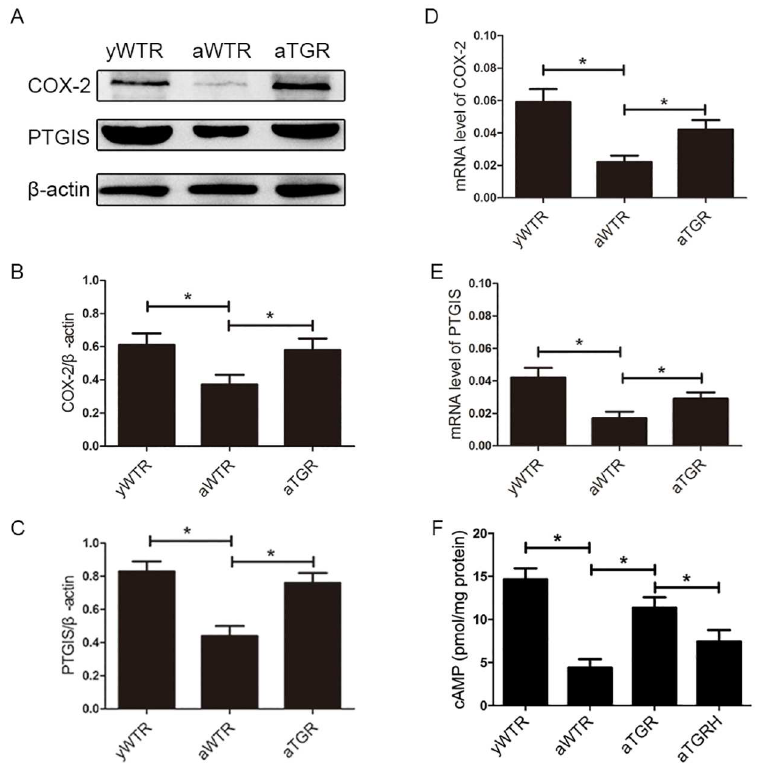
Fig 5. Expression levels of COX-2, PTGIS and cAMP. (A): Representative western blot results of COX-2 and PTGIS in corpus cavernosumof three groups. (B) and (C): Expressions of COX-2 and PTGIS with β -actin as the loadingcontrol in the corpus cavernosumof three groups were presentedthrough bar graphs. (D) and (E): RelativemRNA level in corpus cavernosum of rats in all groupsby RT-PCR using the 2- Δ Ct method. (F): cAMP concentrations of all groupsassessed by ELISA method. The data are expressedas mean ± s.d. * P < 0.05when comparing the two groups under each end of the capped